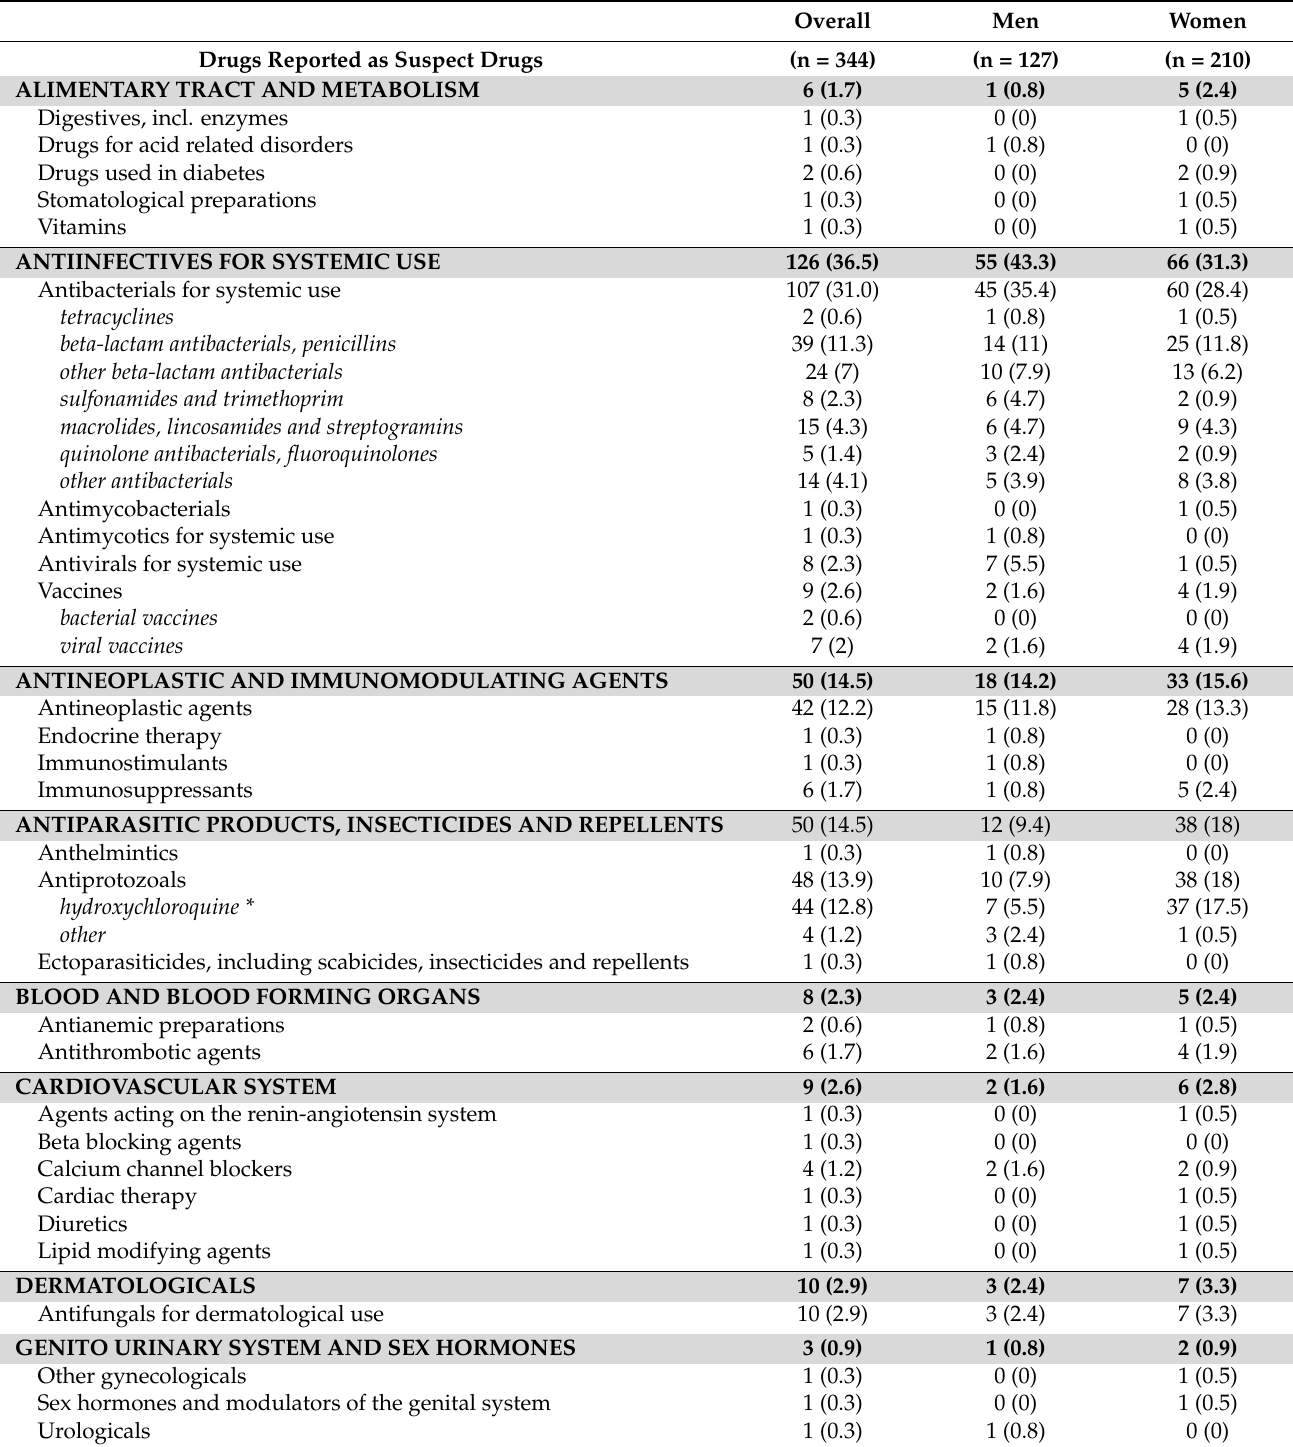
Table 3. Information on the reported suspect drugs for the 297 identified patients. Patients may contribute more than one drug each. Overall Men